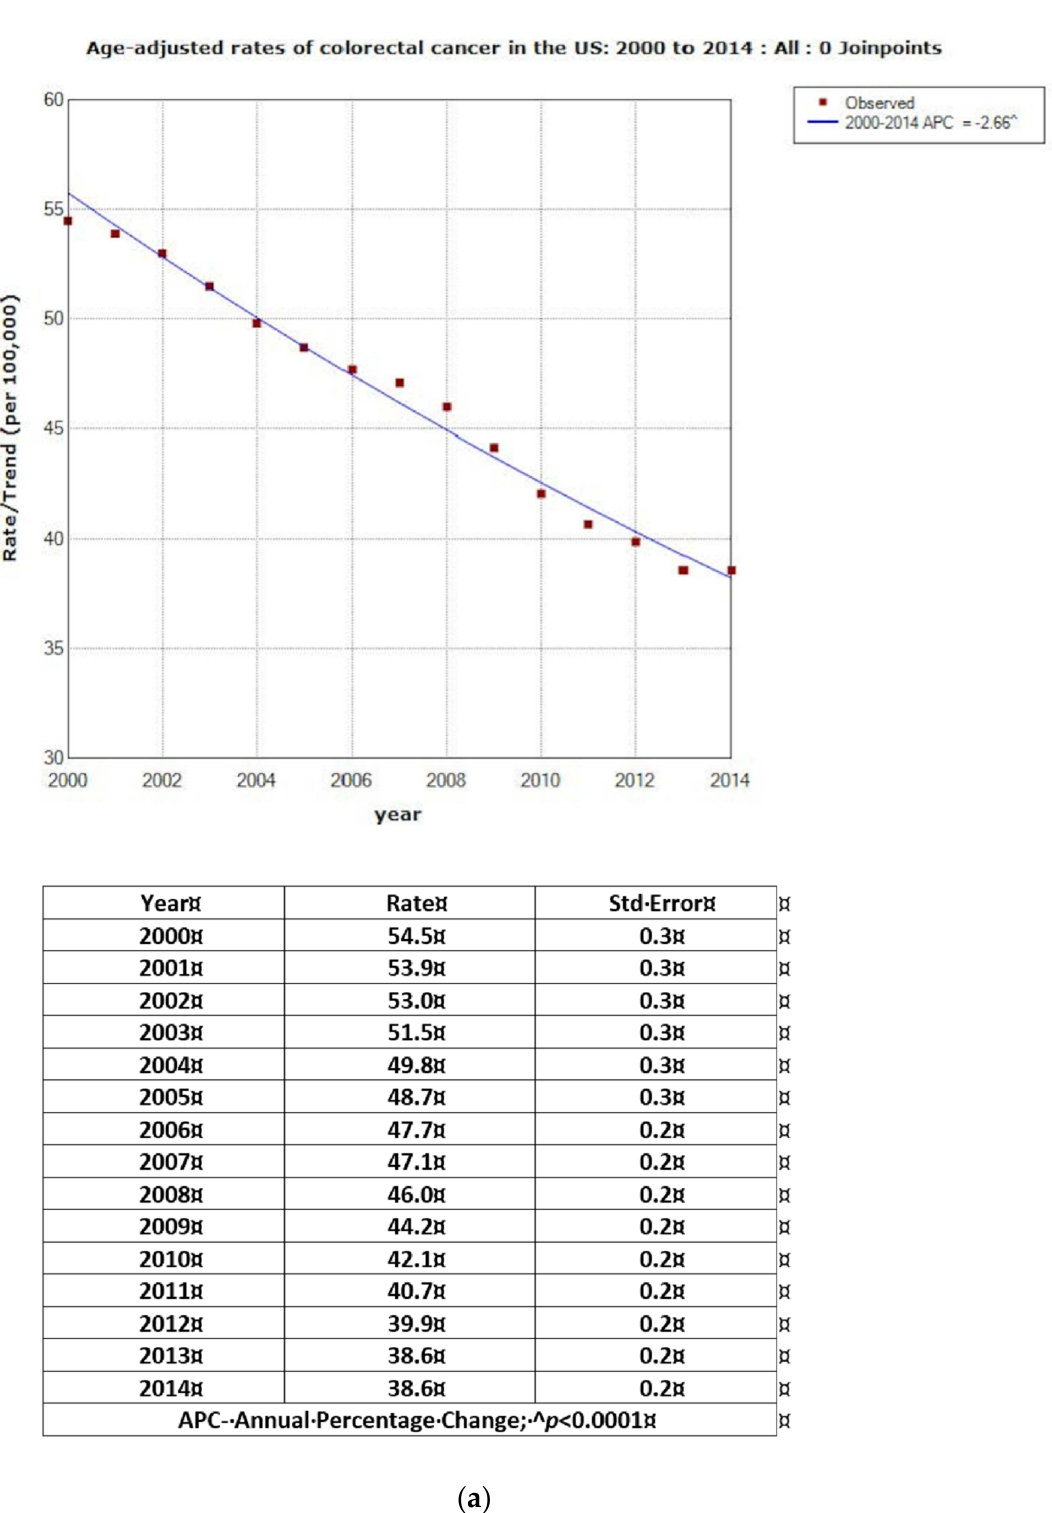
Figure 1. Cont Figure 1. Cont .